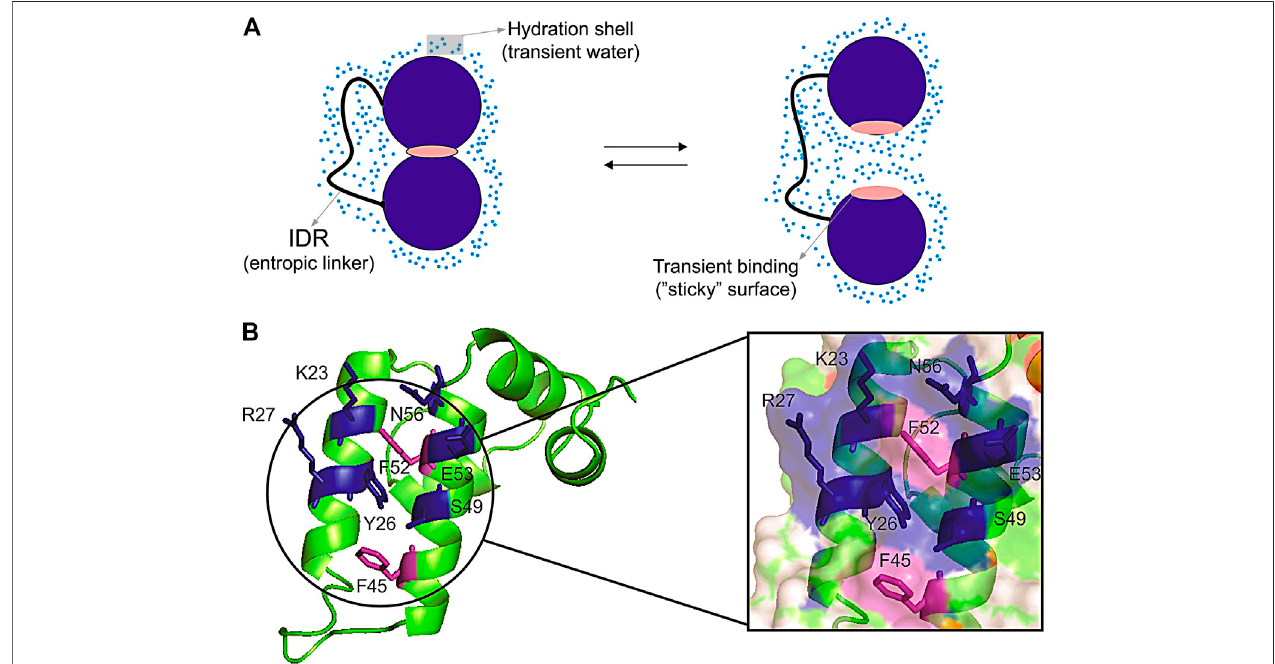
FIGURE 3 | Representation of transient interdomain interactions and surface cluster patch. (A) Scheme of a hypothetic open/close equilibrium being regulated through inter-domain transient interaction. The twodomains (blue circumference) linked by an intrinsicallydisordered region (IDR) are interacting in a close conformation through the transient binding of a “ sticky ” surface (pink), and the solvent-induced interaction in an open conformation. The transient binding sites ( “ sticky surfaces ” ) can be formed by defective packing, which may lead to insuf fi ciently dehydrated hydrogen bonds and exposed hydrophobic residues. The blue dots denote the hydration shell formed by transient water molecules; (B) The Sis1 J-domain showing the surface patch with exposed hydrophobic residues (purple) protected by polar side chains (blue). This surface patch presents transient inter-domain interactions which are pivotal for protein recognition (Pinheiro et al.,